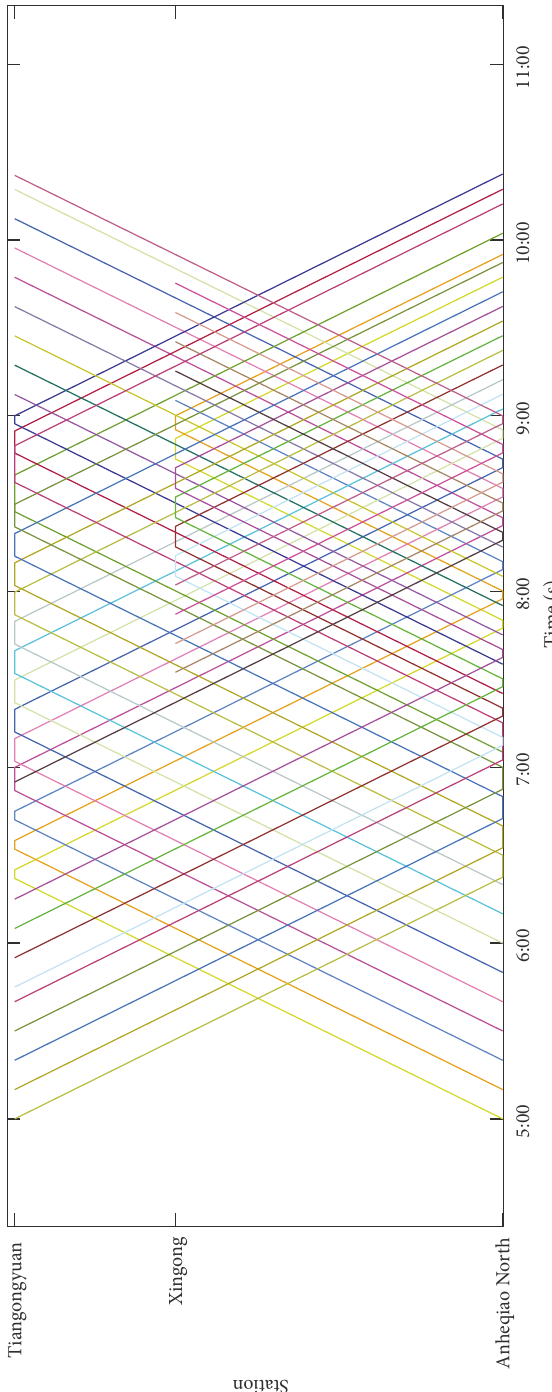
Figure 10: Optimal train schedule with short turning strategy for case